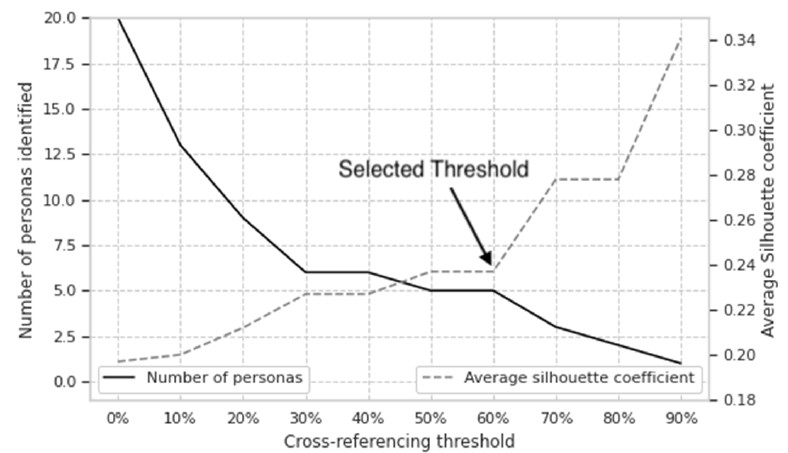
Figure 2. The number of engagement personas (solid, black line; left y-axis) for each cross-referencing threshold (x-axis) and the corresponding average silhouette coefficient (gray, dashed line; right y-axis). We selected 60% based on obtaining the highest silhouette coefficient that captured a large percentage (76%) of members. Lowering to 40%, for example, only increased the percentage of members to 80% but would have added an additional engagement persona with a small n that overfitted the data. In contrast, raising it to 70% would have dropped the percentage of captured members to 52%.